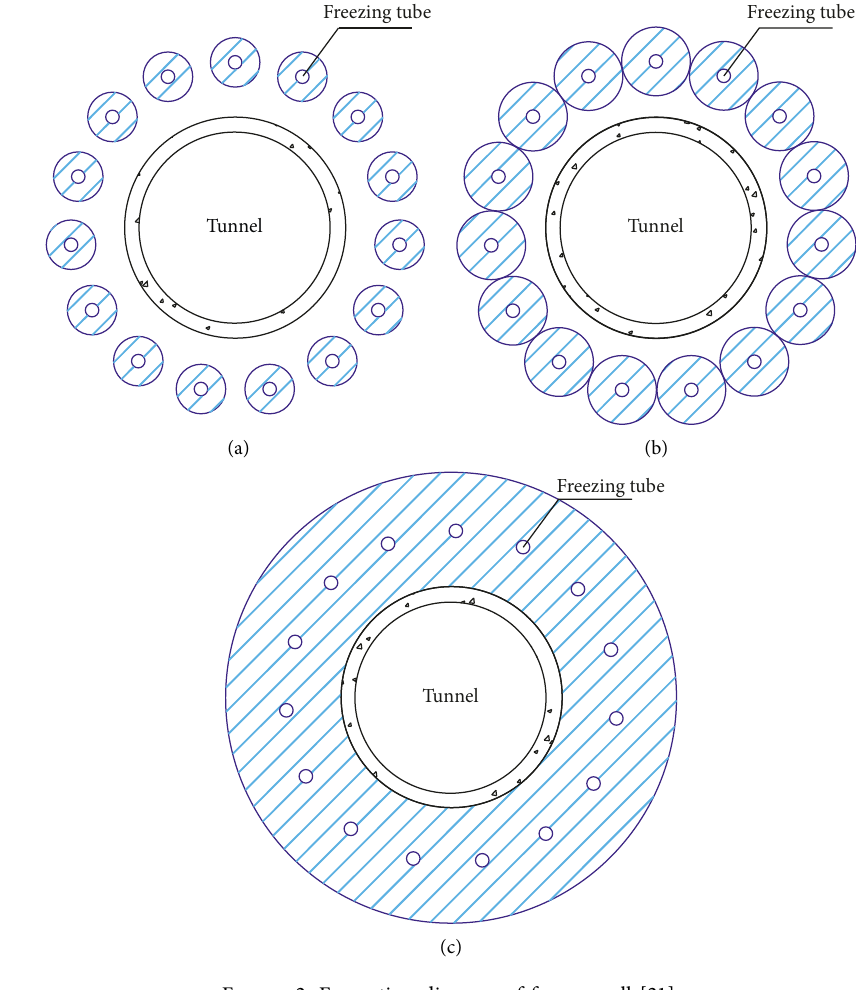
Figure 2: Formation diagram of frozen wall [21].